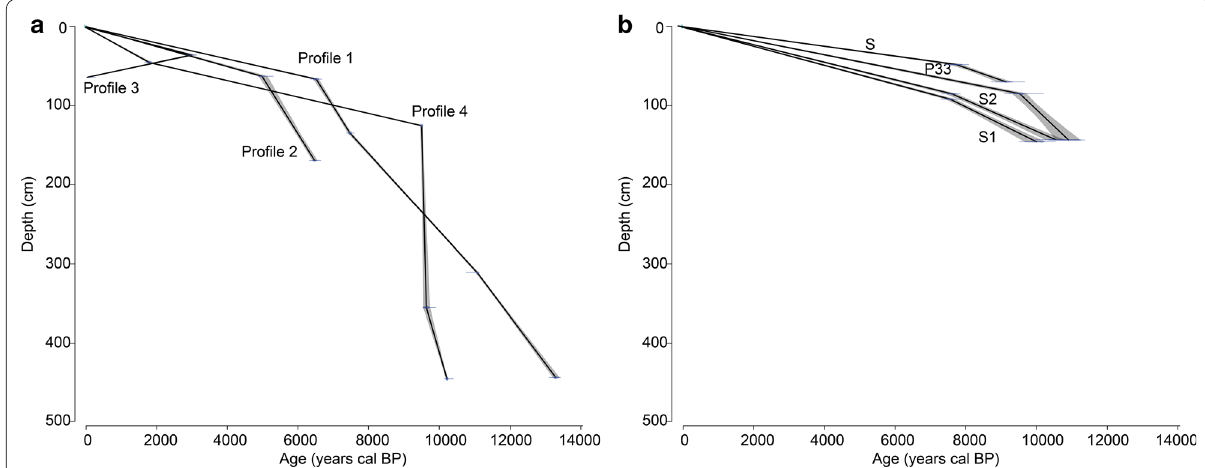
Fig. 6 Age-depth profiles (plotted using Clam; Blaauw 2010) of the investigated profiles with a profiles 1–4 (cf. Fig. 4) and b S1, S2, P33, S